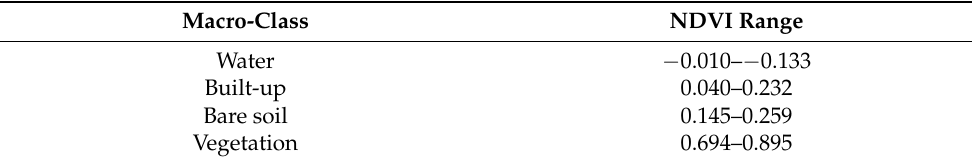
Table 2. Suitable NDVI ranges identified for the LULC